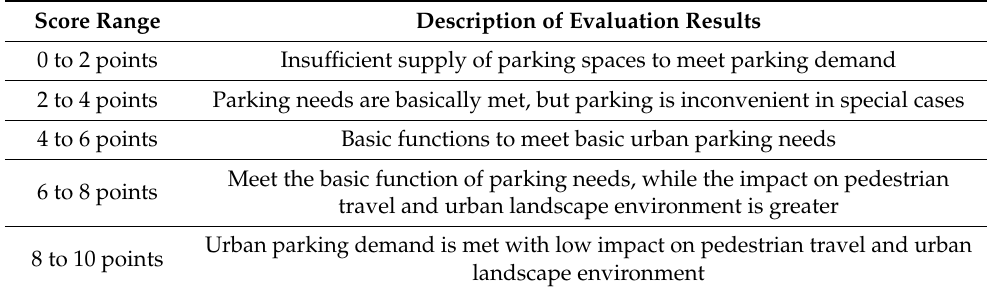
Table 5. Evaluation result score range of urban parking